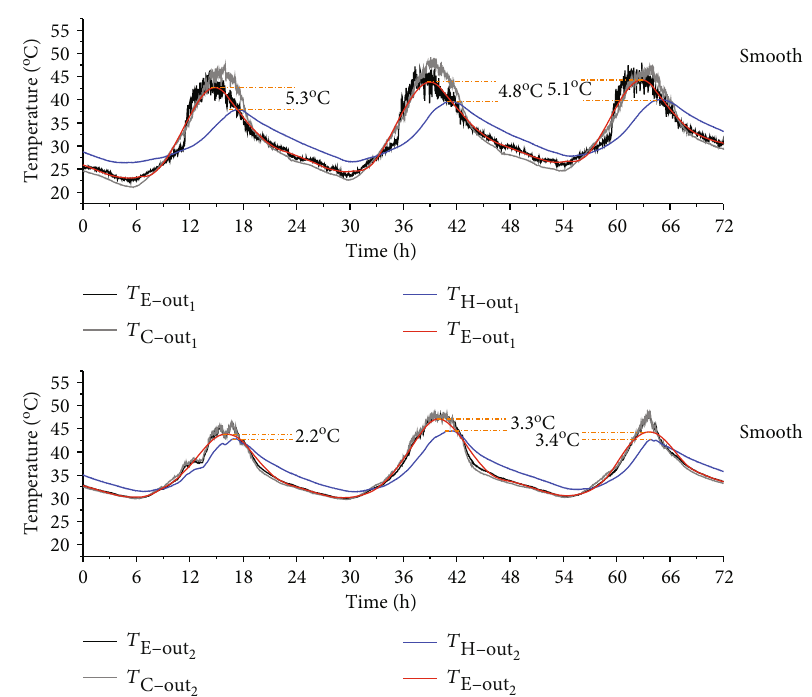
Figure 9: External side temperatures of the south wall and the Trombe